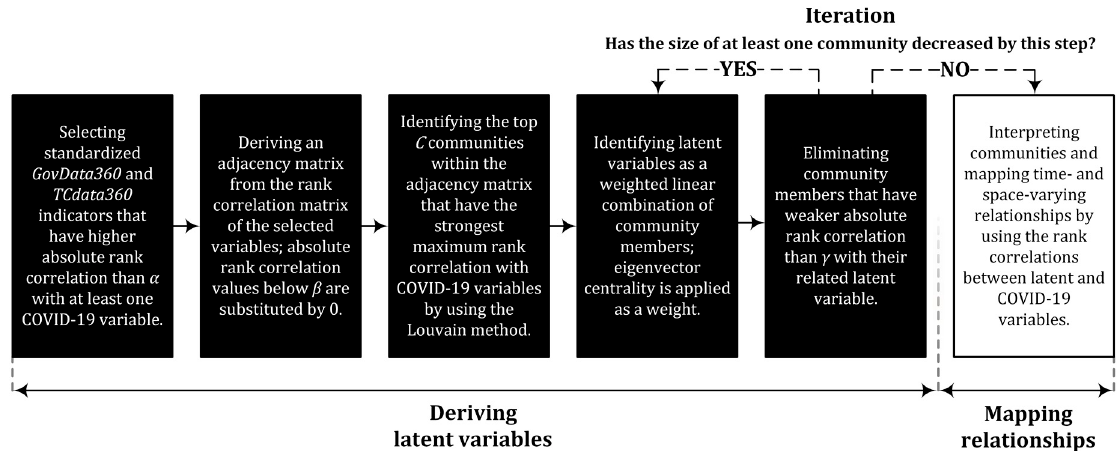
Figure 1. Calculation steps. The calculation process can be divided into six steps. The first five steps are responsible for creating communities characterized by latent variables, and the last one is about the interpretation of the communities and mapping their relationships with COVID-19